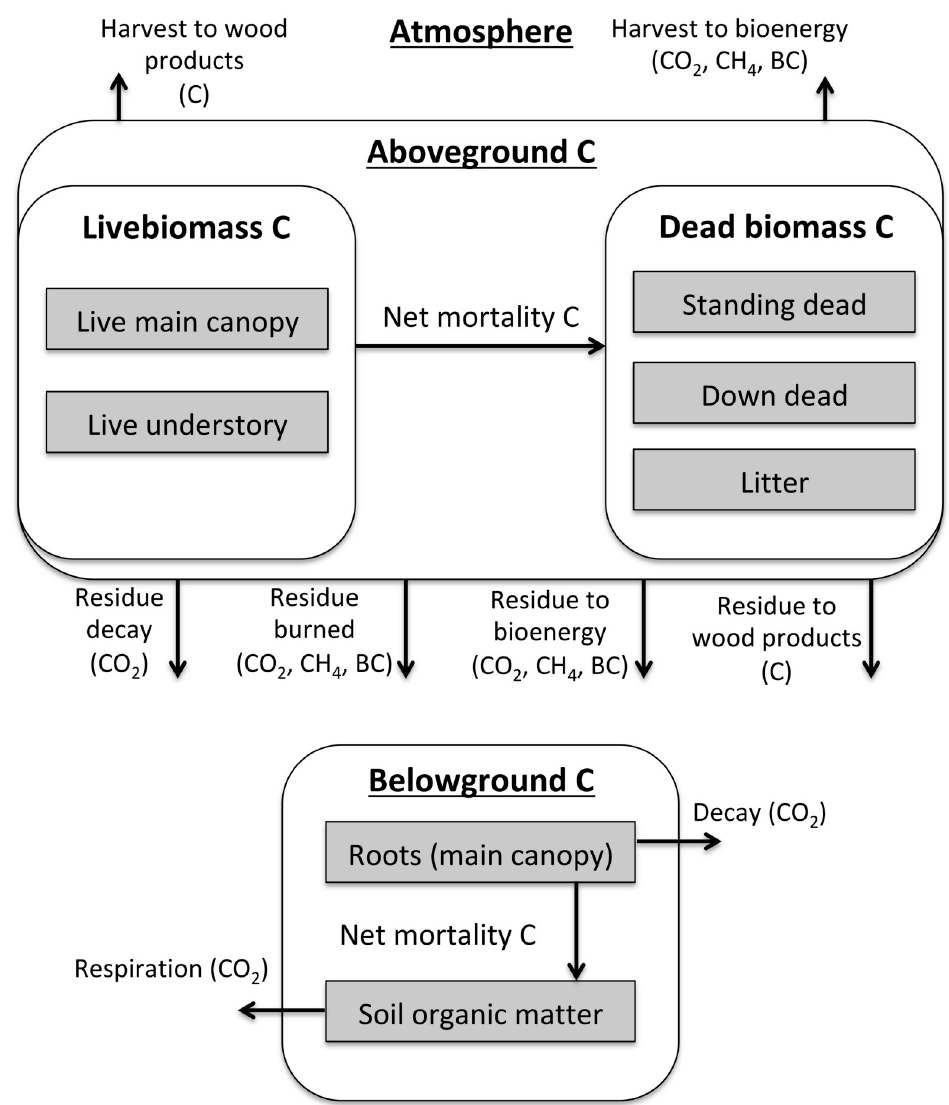
Fig 5. CALAND forest management carbon dynamics. There are two separate pathways to wood products and bioenergy: 1) the traditional harvest pathway and 2) a slash pathway from traditionally uncollected harvest residue and disturbed biomass (understory, down dead, and litter). Discarded wood products decay as CO 2 and CH 4 . These dynamics also apply when Forest is converted to Urban area or Cultivated land.